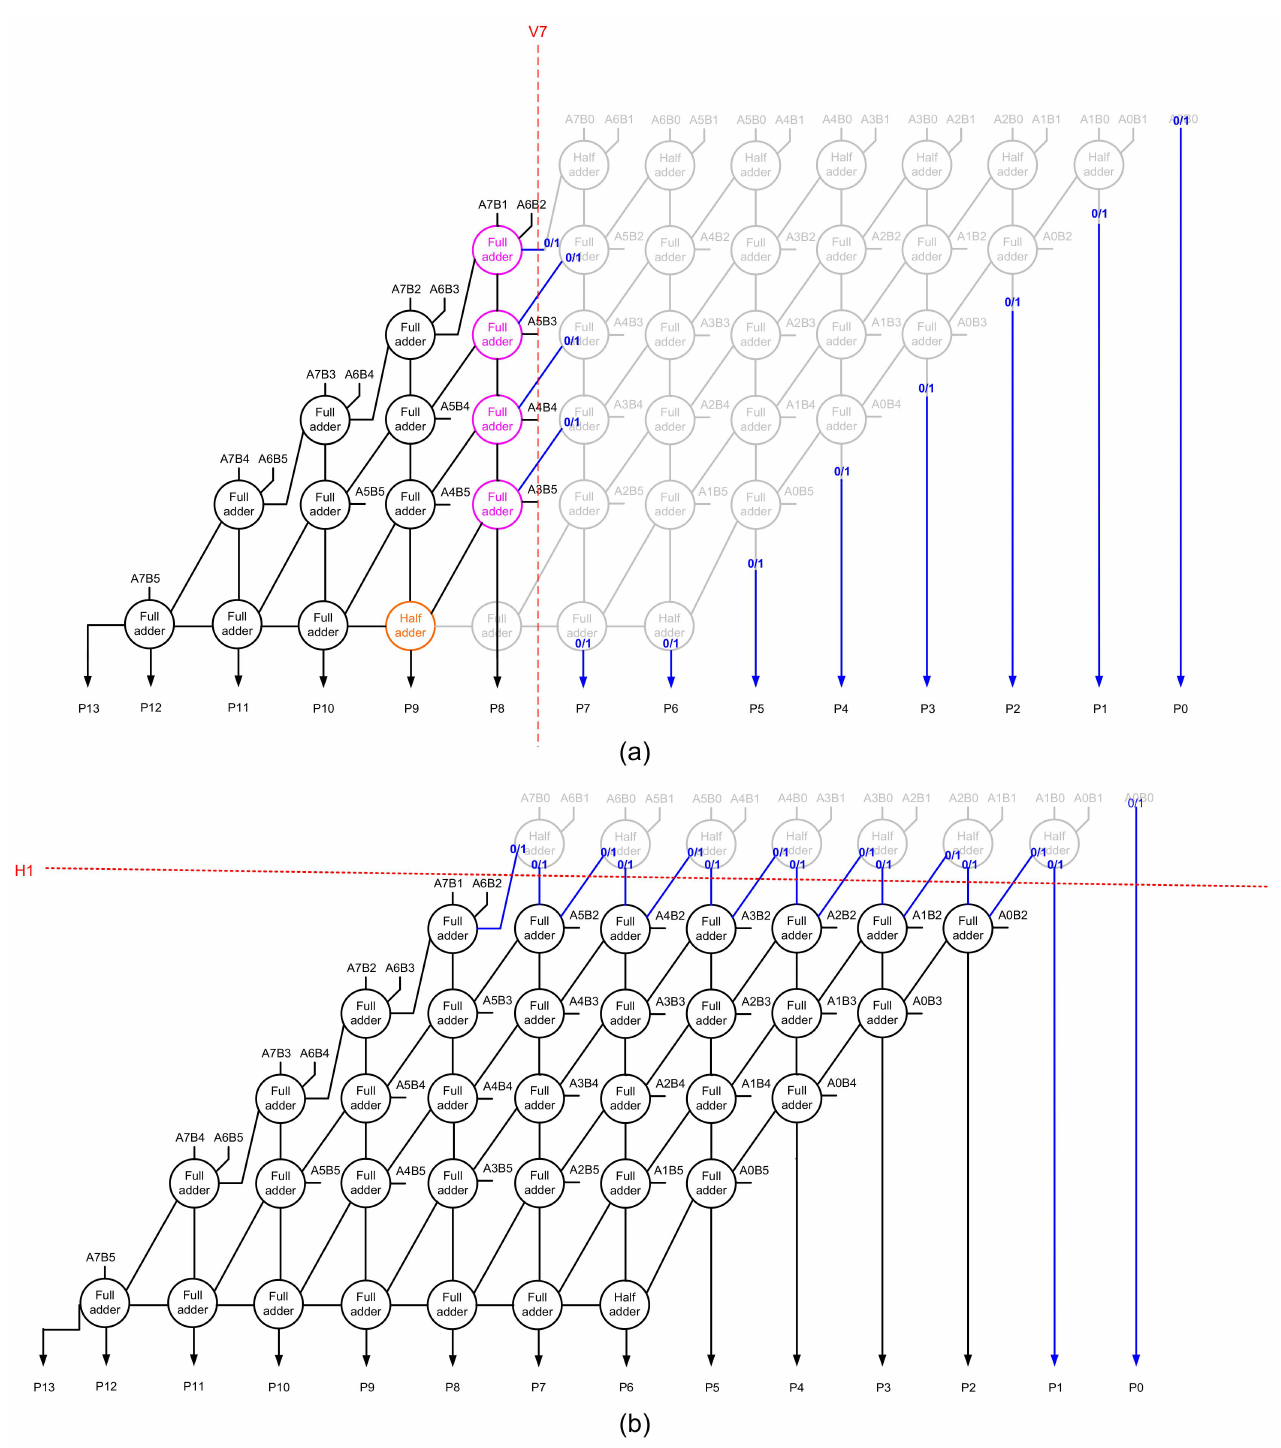
Figure 3. Illustrating the effect of example vertical and horizontal cuts on an accurate array multiplier resulting in approximate array multipliers. ( a ) Vertical cut V7; ( b ) horizontal cut H1. The circuit portions eliminated are shown in light